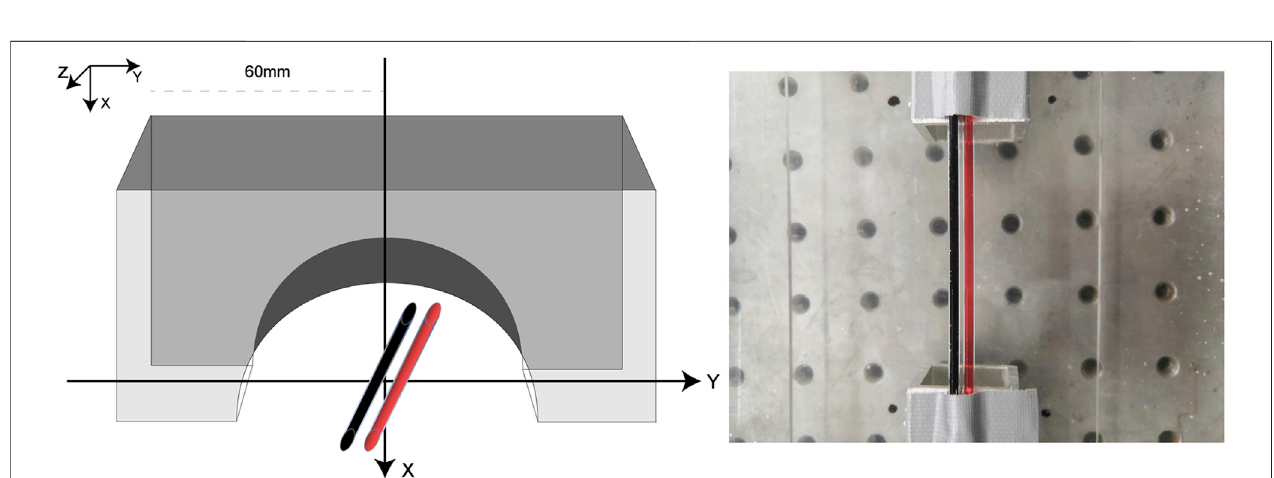
FIGURE 8 | Schematic diagram of the position of the circular array, black ink tube, and PtOEP tube.